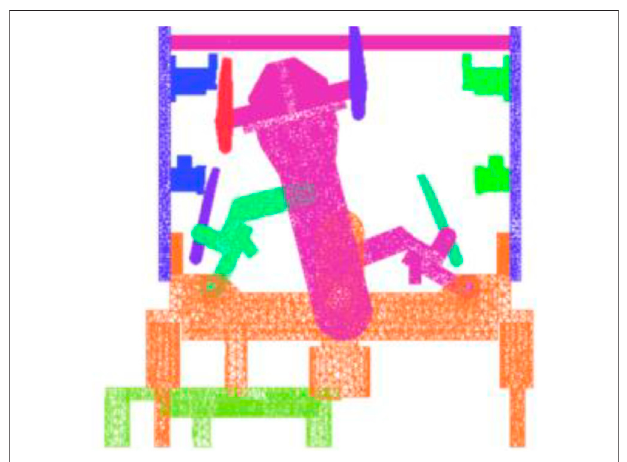
FIGURE 8 | Overall grid of OLTC.